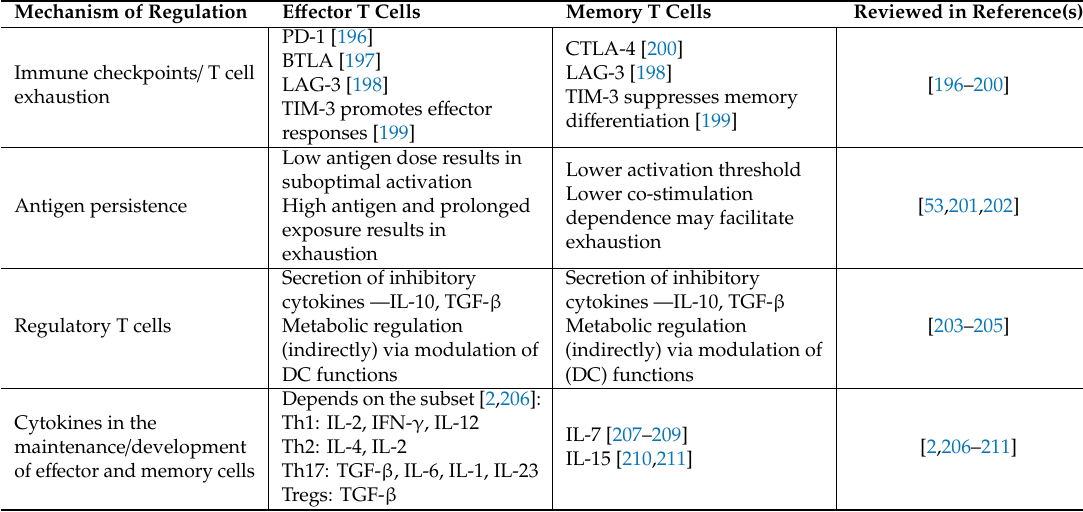
Table 1. Regulation of memory and e ff ector CD4 + T cells. Abbreviations used: programmed cell death protein 1 (PD-1), B-and T-lymphocyte attenuator (BTLA), lymphocyte-activation gene 3 (LAG-3),